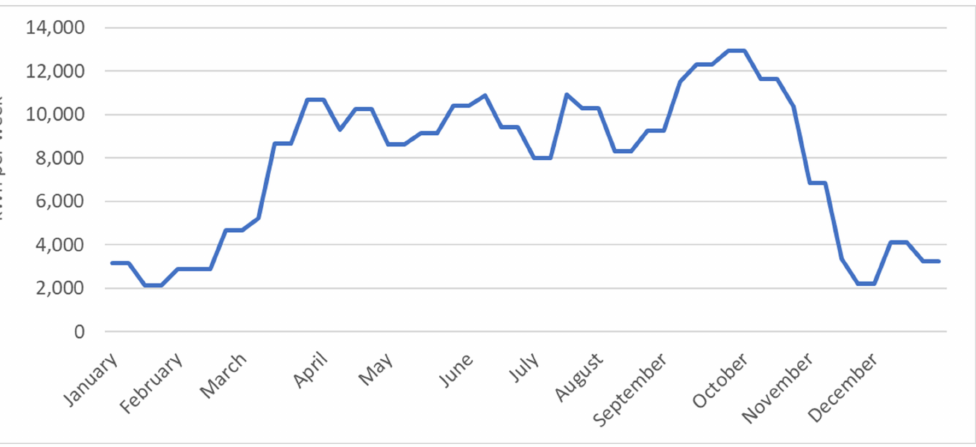
Figure 3. Annual distribution of fuel requirements in a dairy farm with crop and forage production. Source: survey dairy farm